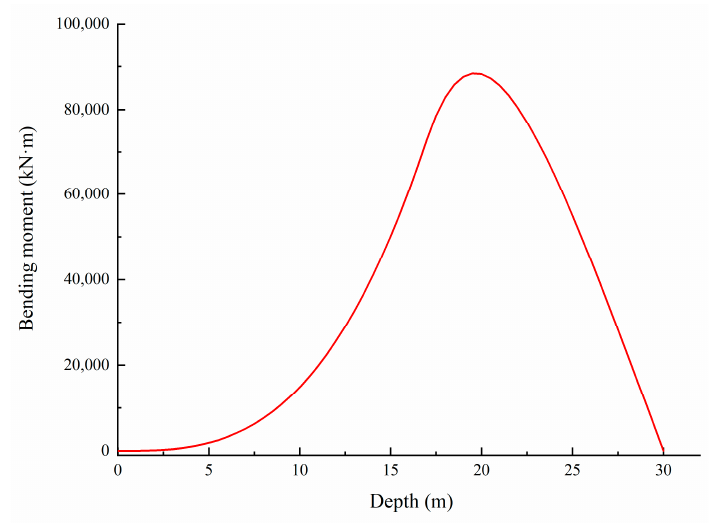
Figure 12. Designed bending moment distribution of the anti-slide pile.